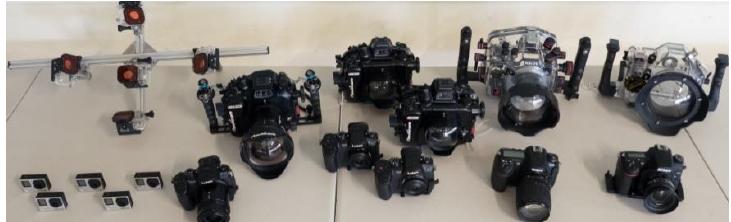
Figure 1. Tested underwater camera systems: three high quality off-the-shelf digital cameras (PL41, N750 and N300), a stereo system with two mirrorless cameras (PL51-PL52) and a 5-head camera system with action cameras (5-